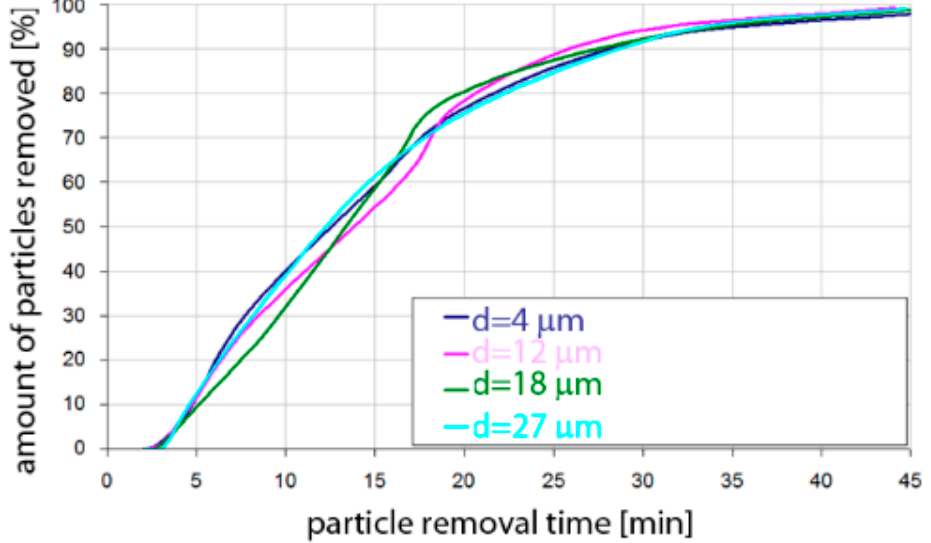
Figure 20. Share of removed non-metallic MnS inclusions from the analysed ladle in the case of argon flow of 25 L/min through the 42CrMo4 steel.